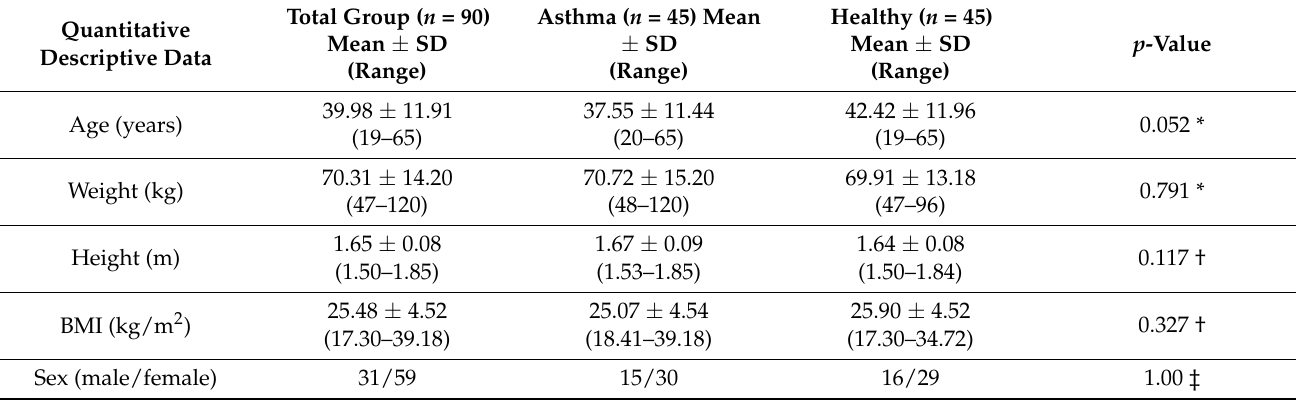
Table 1. Quantitative sociodemographic and descriptive data for patients diagnosed with asthma, healthy matched-paired controls and total